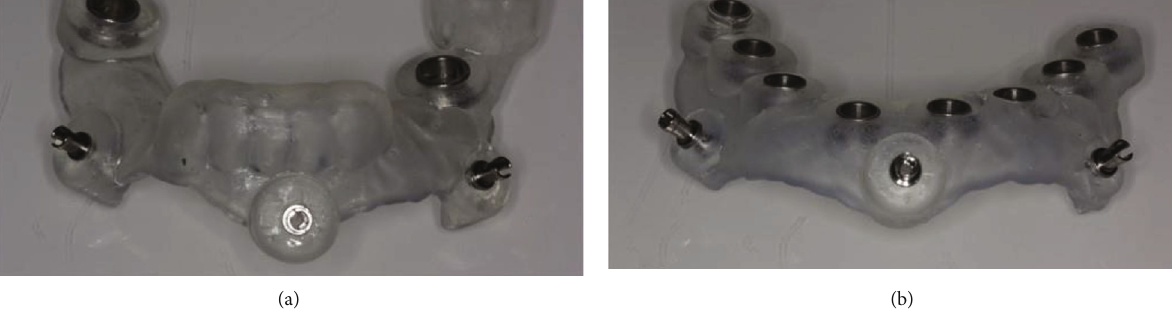
Figure 3: Positioning surgical template (a) and full-guided surgical template